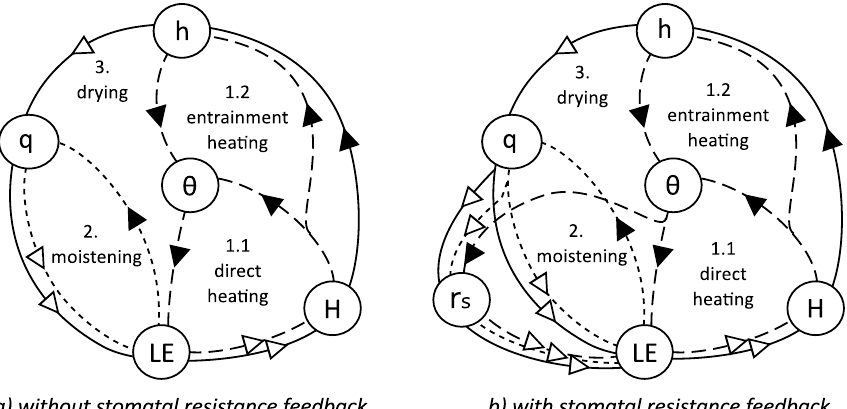
Figure 2. Overview of the most relevant feedback loops between the land surface and the atmospheric boundary layer for forest and grassland without and with the active role of the plant physiology (left diagram comes from van Heerwaarden et al., 2009). Closed triangles show positive correlations, and open triangles negative ones. Each line style describes a distinct feedback loop. LE is the evapotranspiration, H is the sensible heat flux, θ and q are the potential temperature and the specific humidity of the atmospheric boundary layer, h is the height of that layer and r s is the stomatal